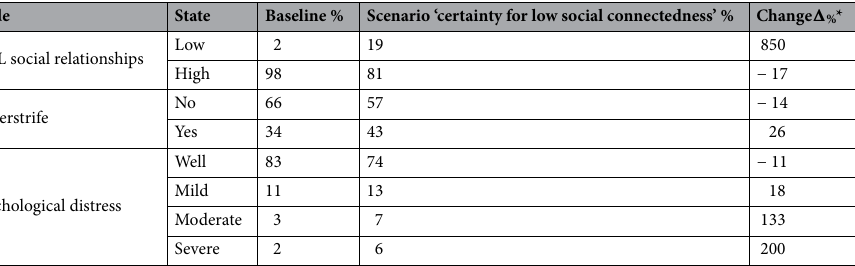
Table 6. Changes from baseline in affected nodes with Scenario 4 ‘certainty for low social connectedness’. P evidence − P baseline * (cid:31) % = P baseline ×